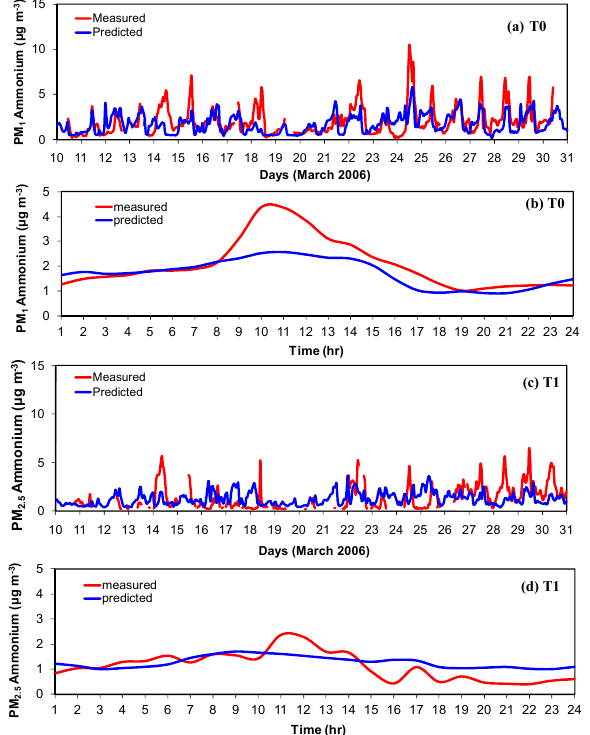
Figure 7: Comparison of model hourly and diurnal predictions against measurements for PM 1 ammonium taken at T0 (a, b) and PM 2.5 ammonium taken at T1 (c, d) during the MILAGRO Fig. 7. Comparison of model hourly and diurnal predictions against campaign. measurements for PM 1 ammonium taken at T0 (a, b) and PM 2 . 5 ammonium taken at T1 (c, d) during the MILAGRO campaign.